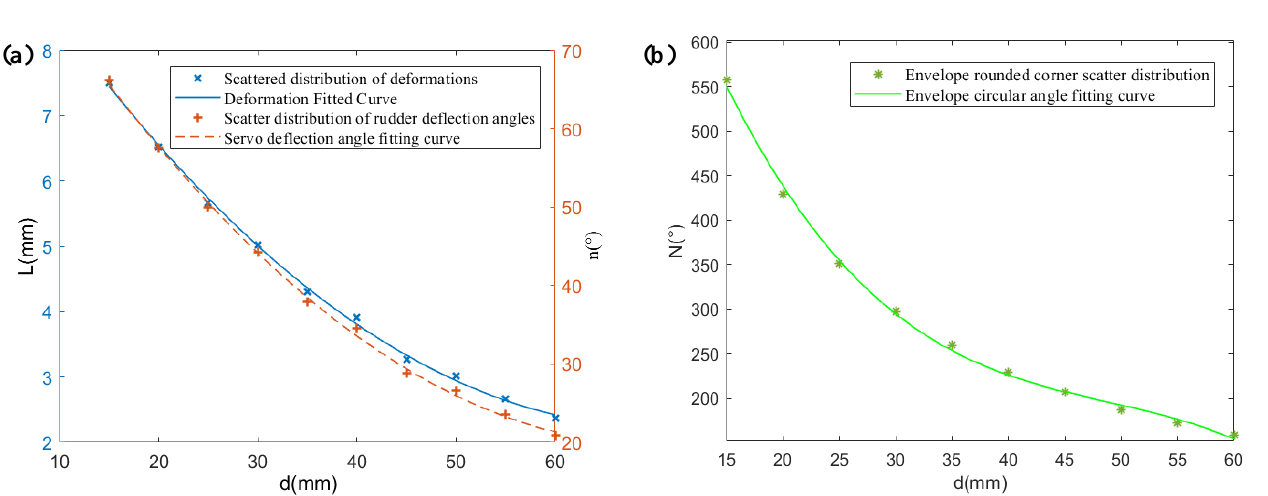
has sufficient resistance to ficient resistance to deformation.